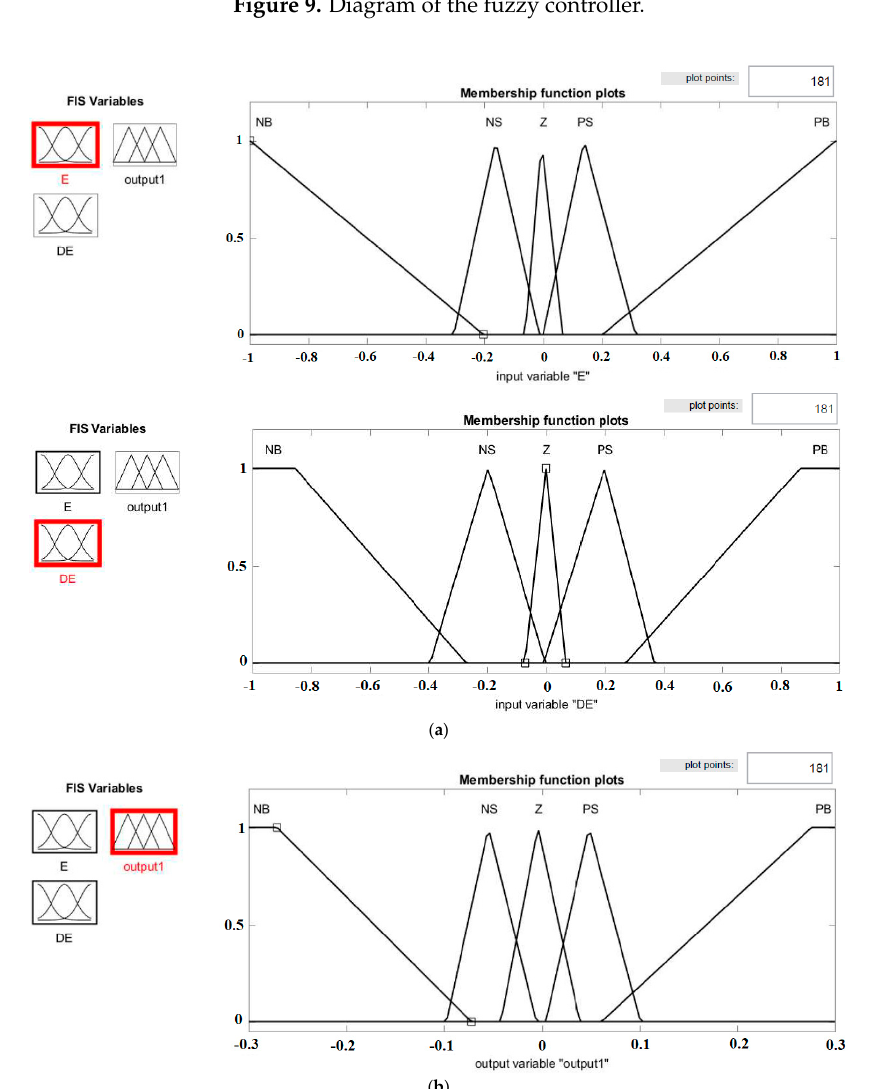
Figure 10. ( a ) Membership functions of the input variable; ( b ) membership functions of the output variable.